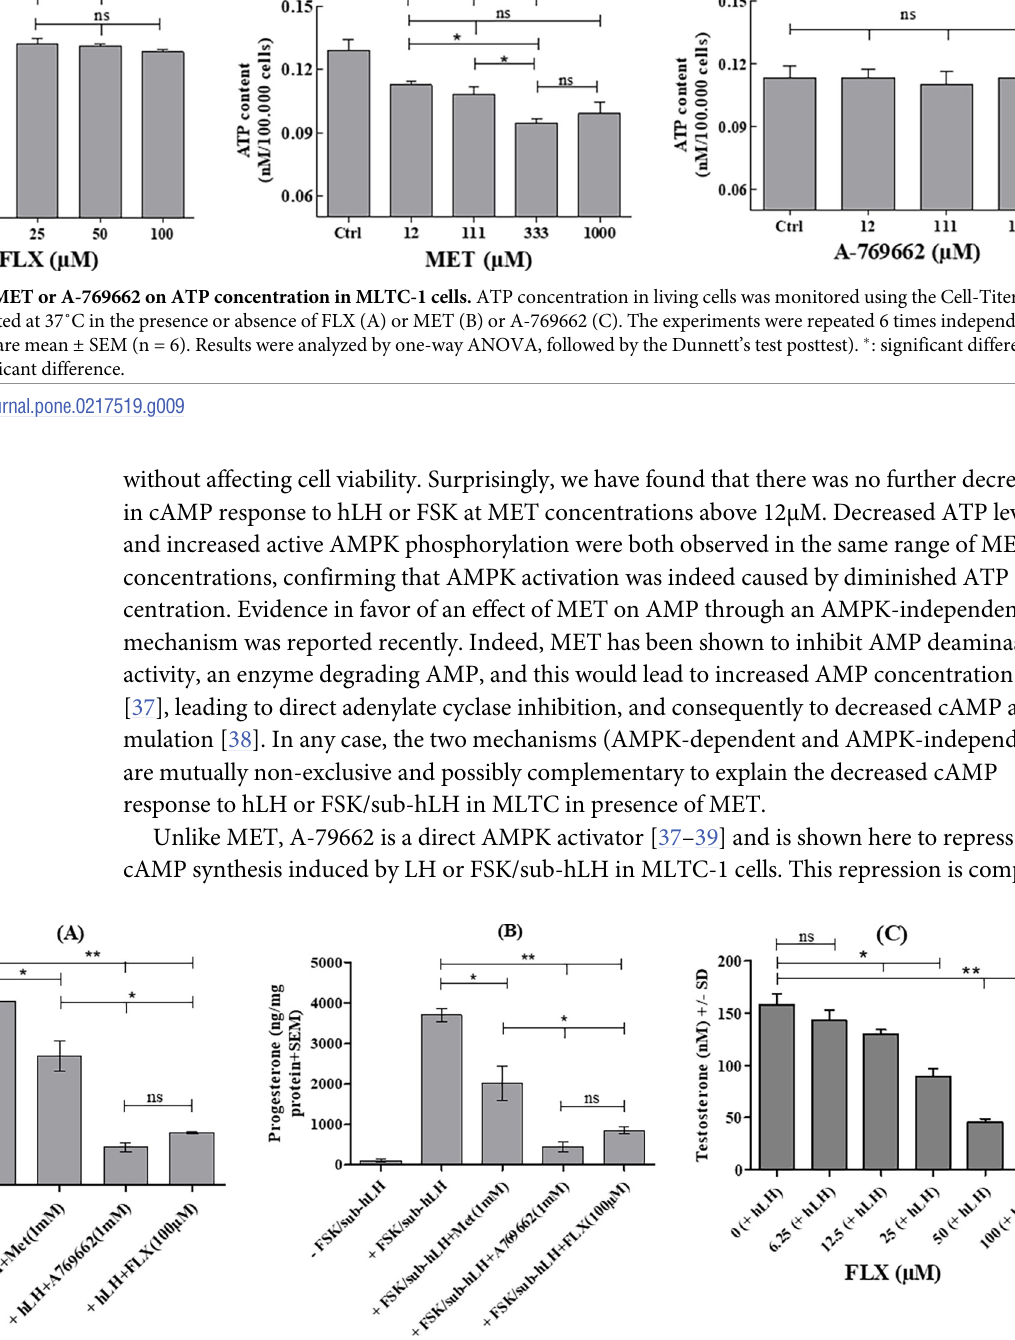
Fig 10. Effect of fluoxetine in hLH or FSK/sub-hLH -promoted steroid production in MLTC-1 and primary Leydig cells. (A), (B) MLTC-1 cells were preincubated with or without FLX (or MET, or A-769662) for 1 hour and then the cells were stimulated for 3 hours with hLH or FSK/sub-hLH before progesterone productions were measured. (C) Primary Leydig cells were preincubated with or without FLX for 1 hour and then the cells were stimulated for 3 hours with hLH before testosterone productions were measured. Data are means ± SEM of 3 independent experiments performed in duplicate (n = 3). Results were analyzed by one-way ANOVA, followed by the Dunnett’s test posttest). � : significant difference ( � P < 0.05; �� P < 0.01), ns: no significant difference.